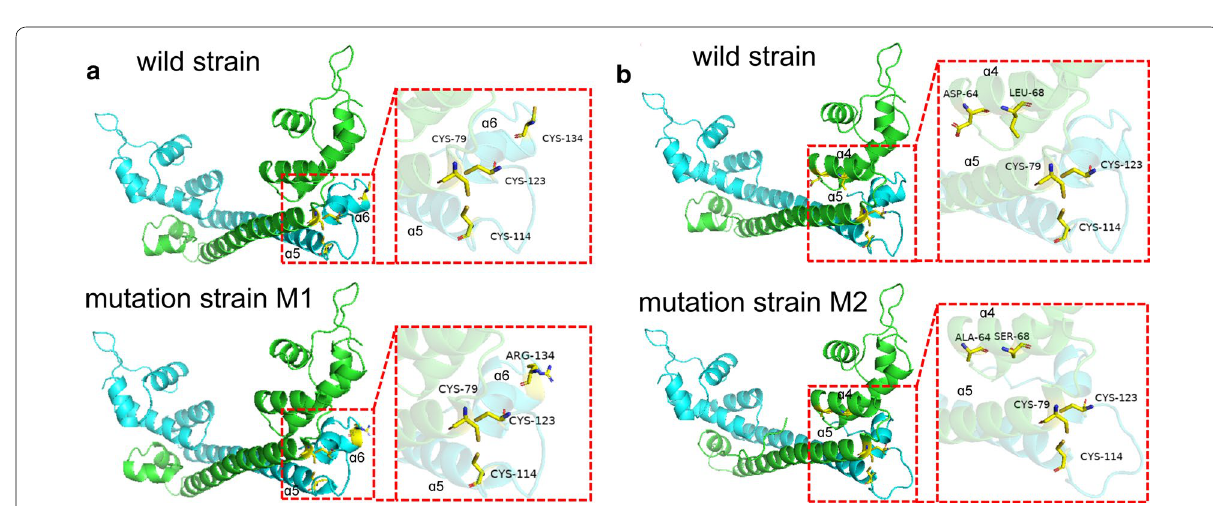
Fig. 8 Local model comparison of protein PbrR in a mutant strain M1 and b mutant strain